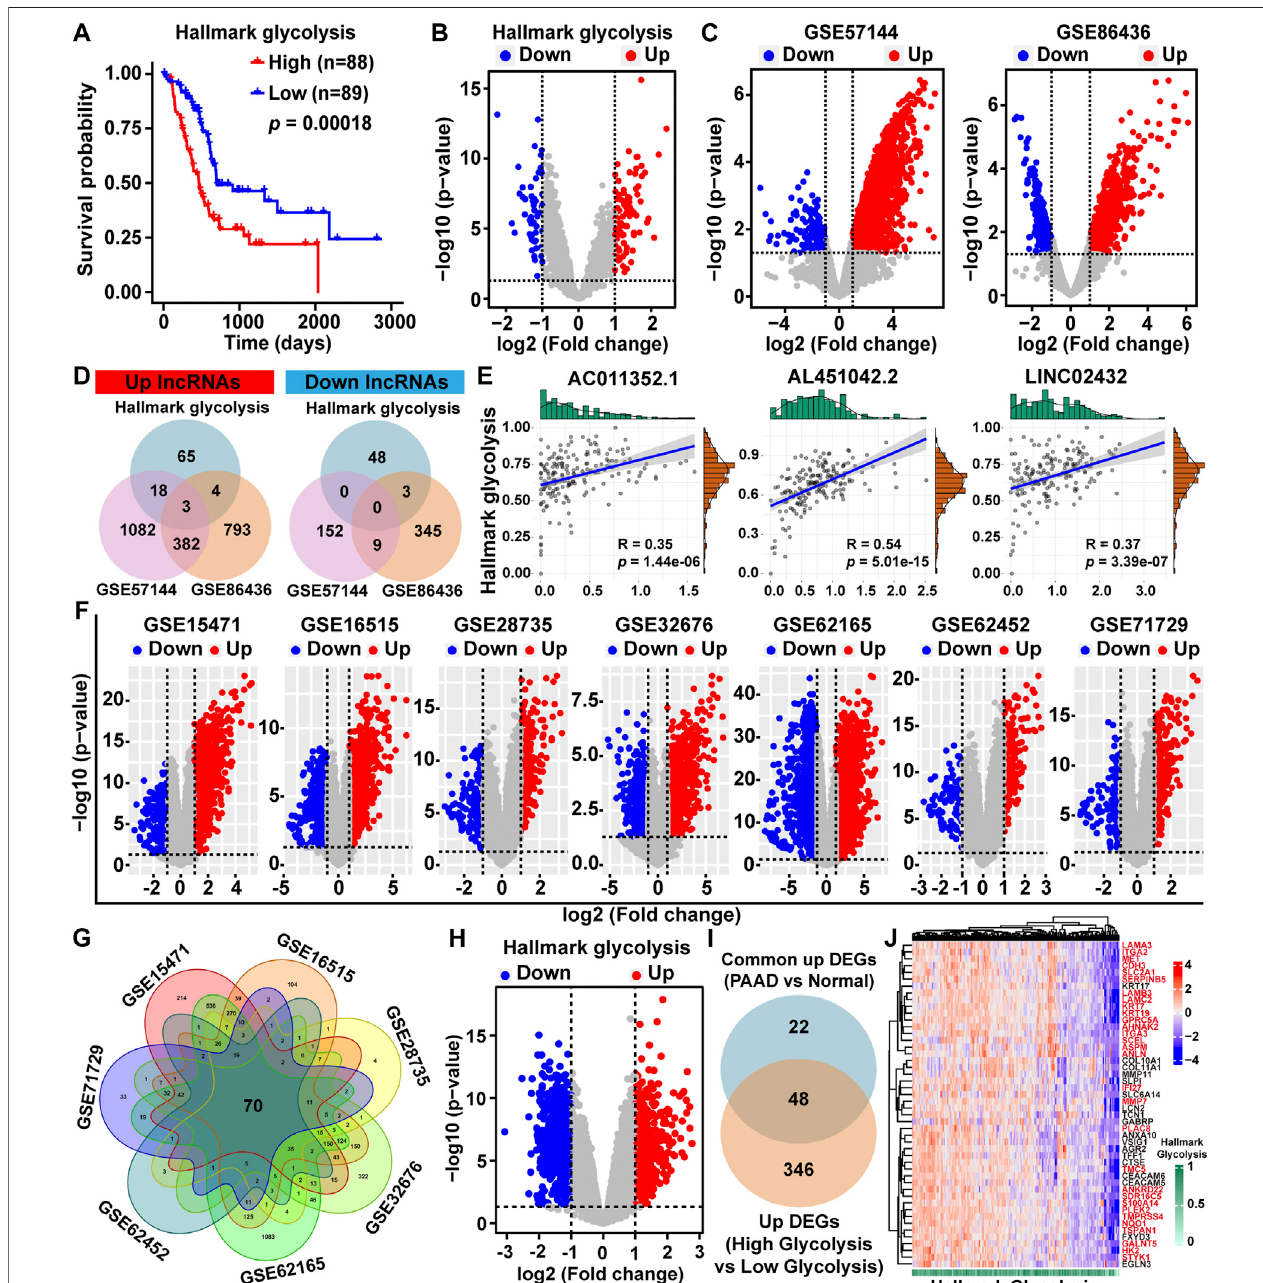
FIGURE1| Identi fi cationofglycolysis-relateddifferentiallyexpressedlncRNAsandmRNAs. (A) Kaplan-MeiersurvivalanalysisofPAADpatientsbasedonhallmark glycolysis score. (B) Volcano map of the DELs among high-glycolysis and low-glycolysis groups. (C) DELs volcano maps between PAAD tissues and normal tissues in the GSE57144 and GSE86436 datasets.Upregulated lncRNAs were indicatedby red dots and downregulated lncRNAs wereindicated byblue dots. (D) Venn diagram depictingtheoverlapamongthreesetsofDELs. (E) ThePearsoncorrelationanalysiswasperformedtoevaluatetheassociationbetweenglycolysisssGSEA score and three lncRNAs. (F) Volcano plots of DEGs between PAAD tissues and normal tissues in the GSE15471, GSE16515, GSE28735, GSE32676, GSE62165, GSE62452,andGSE71729datasetsdownloadedfromtheGEOdatabase (G) VenndiagramofupregulatedDEGsbasedonthesevenGEOdatasets. (H) DEGsvolcano plot among high-glycolysis and low-glycolysis groups. (I) The overlapping upregulated DEGs wereidenti fi ed byVennplot. (J) Heat map of48upregulated DEGs related to glycolysis.